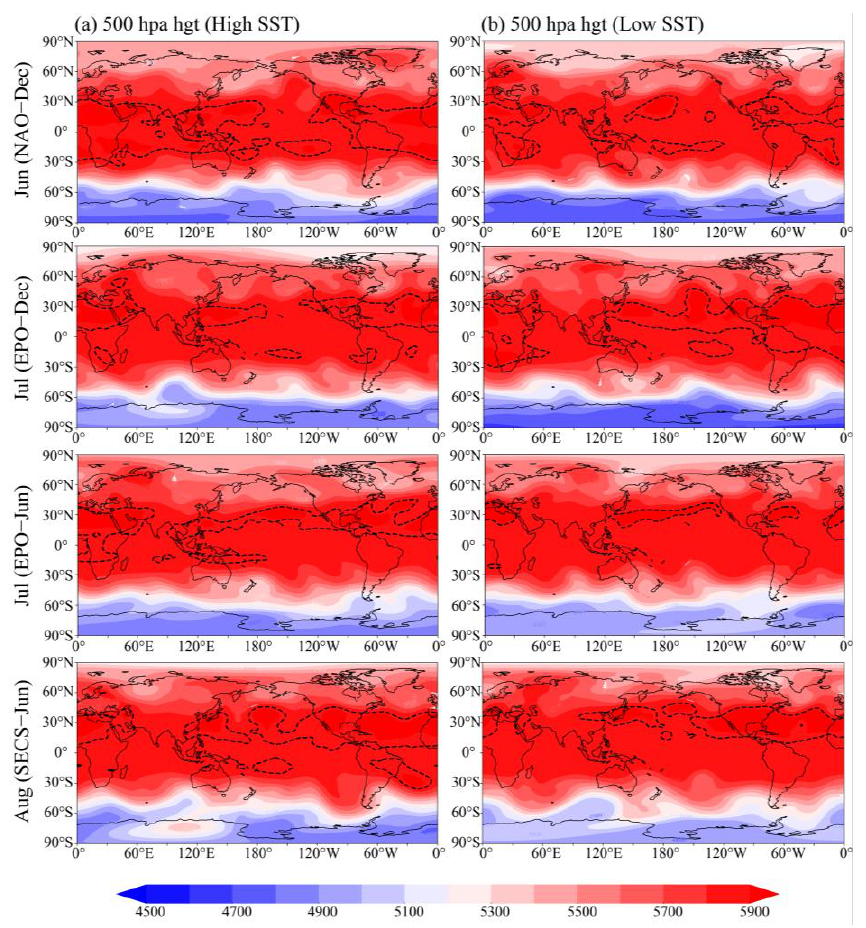
Figure 9. The 500-hpa geopotential height of the summer MLYR in SST anormal years. The black dotted lines define the 5880 gpm; ( a , b ) mark the geopotential height (unit: gpm) anomalies with high SSTs and low SSTs, respectively.